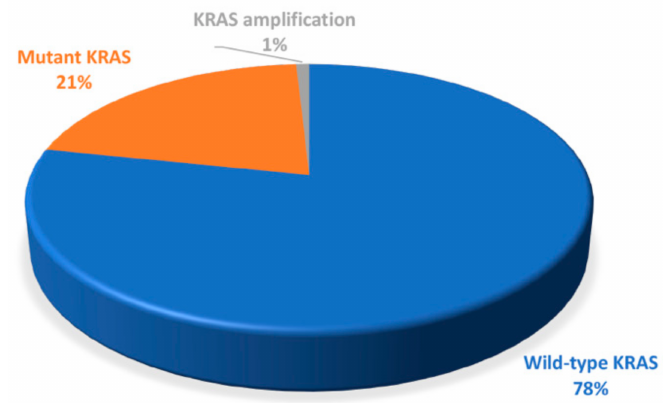
Figure 1. Percentage (approximate values) of mutant samples.